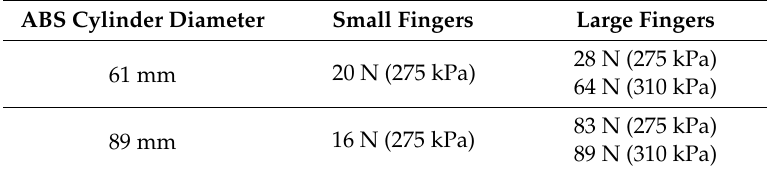
Table 2. Slip test results for both grippers with two ABS cylinder diameters. Test pressure is indicated in